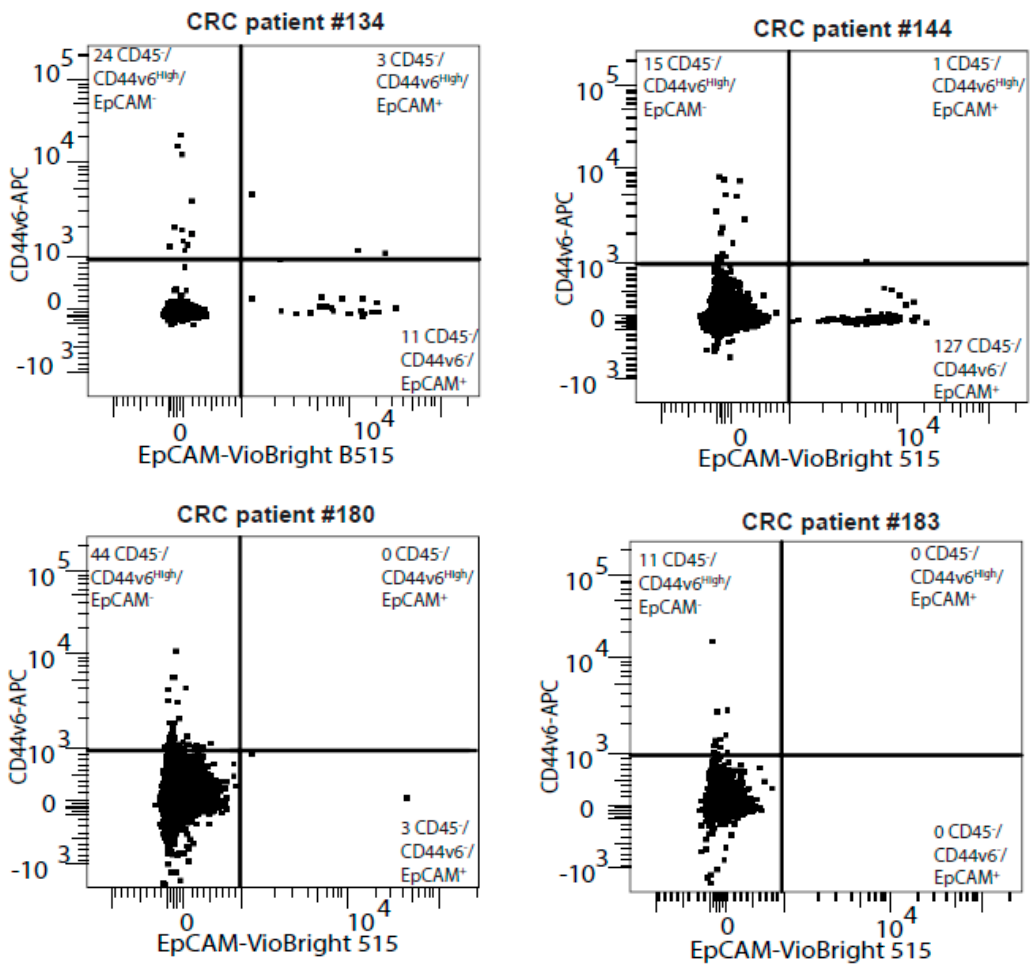
Figure 1. CD44v6 and EpCAM are mutually exclusively expressed in CRC patient blood samples. The four representative FACS plots quantify CD44v6 and EpCAM expression in the CD45-negative cell population from CRC patient blood sam- ples.